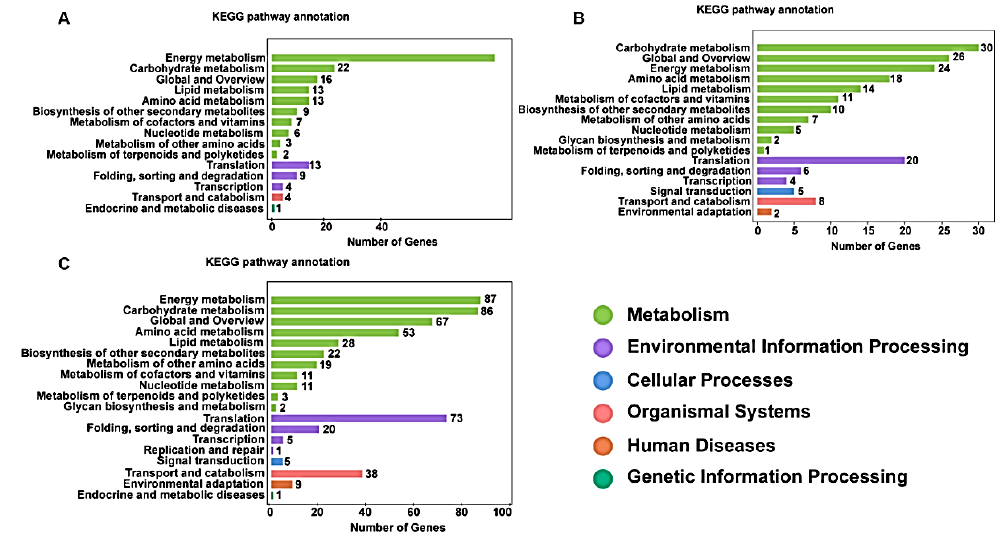
Figure 6. KEGG classifications of differentially abundant proteins (DAPs). The vertical axis shows the annotations of the KEGG metabolic pathways. The horizontal axis represents the gene numbers annotated in each pathway and the proportion relative to the total number of genes. ( A – C ) KEGG pathway classifications for DAPs in KTM3315A compared with TM3315B in the uninucleate stage (UNP), binucleate stage (BNP) and trinucleate stage (TNP), respectively. Each colored column represents a KEGG pathway and the relationships are shown on the right-hand side.